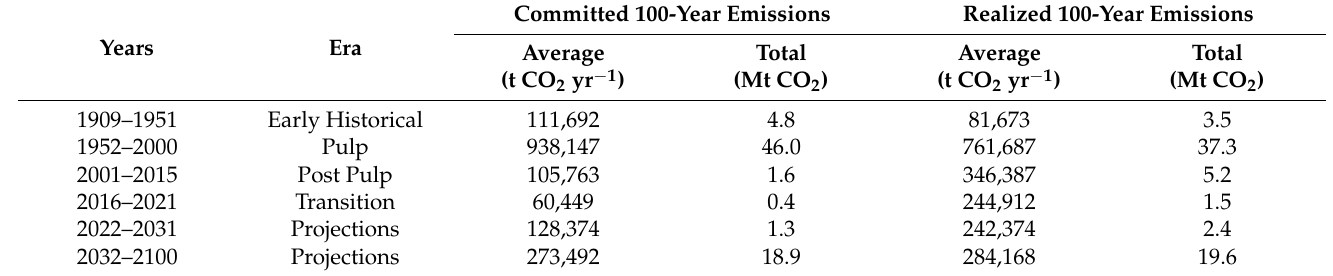
Table 4. Historic (1909–2021) and projected (2022–2100) carbon dioxide emissions from harvested wood products (HWP) on the Tongass National Forest by era. Average (metric tons CO 2 per year) and total (million metric tons CO 2 ) annual committed and realized emissions are based on a 100-year HWP disposition period. See Table S2 for all annual-level estimates as well as cumulative realized emissions for the 1909–2100